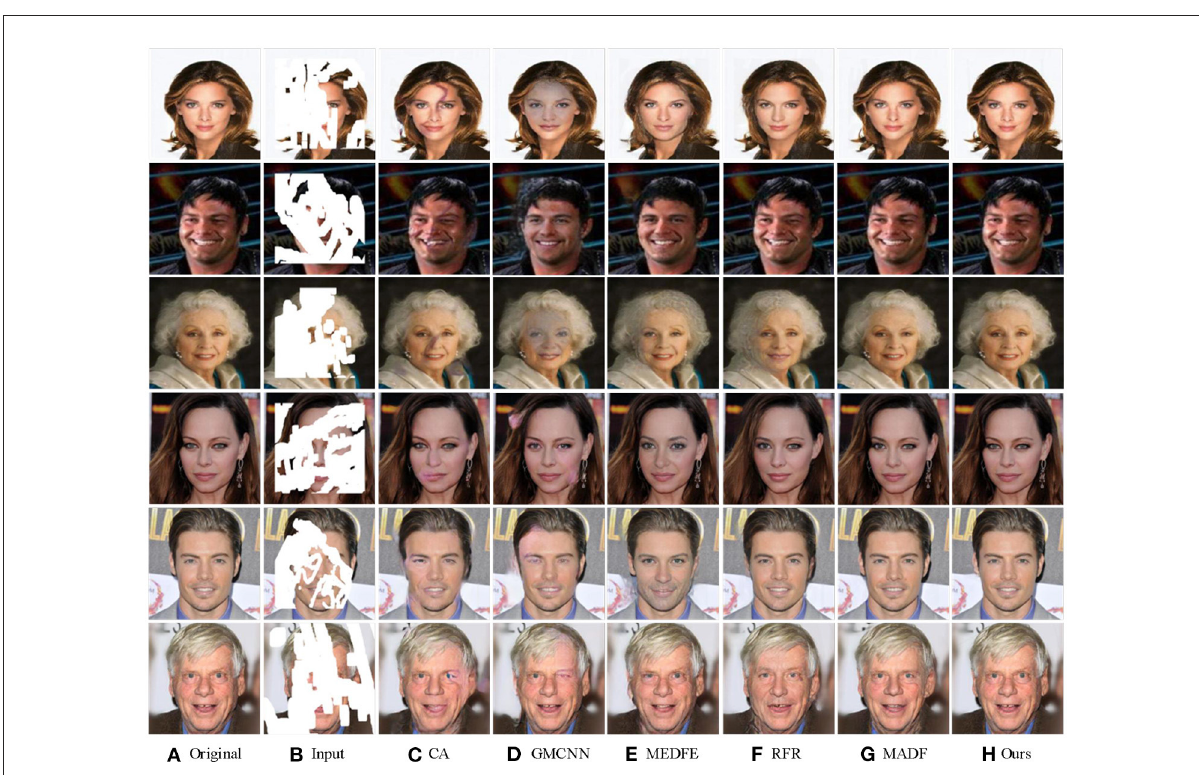
FIGURE6 The comparison of different image inpainting methods on CelebA-HQ and ParisView with irregular masks. The face images are adapted from the celeba-HQ dataset, which comes from Karras et al.